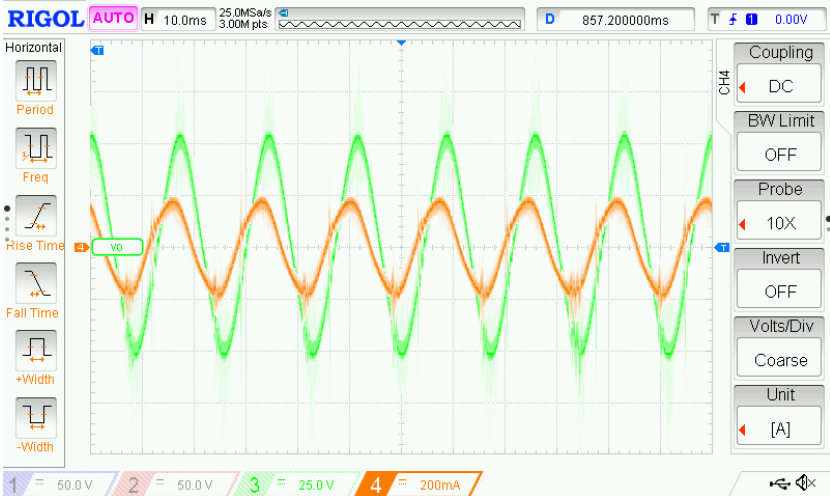
Figure 26. Measurement of output voltage and output current with an RC load. The testbed is then subjected to an RLC load with the same resistor and capacitor values as mentioned previously. This time an inductor of 0.8 H is added to the system. The current in Figure 27 is lagging the voltage waveform, indicating that the load is more inductive. A step change in load is applied, which is noted by an increase in current magnitude.